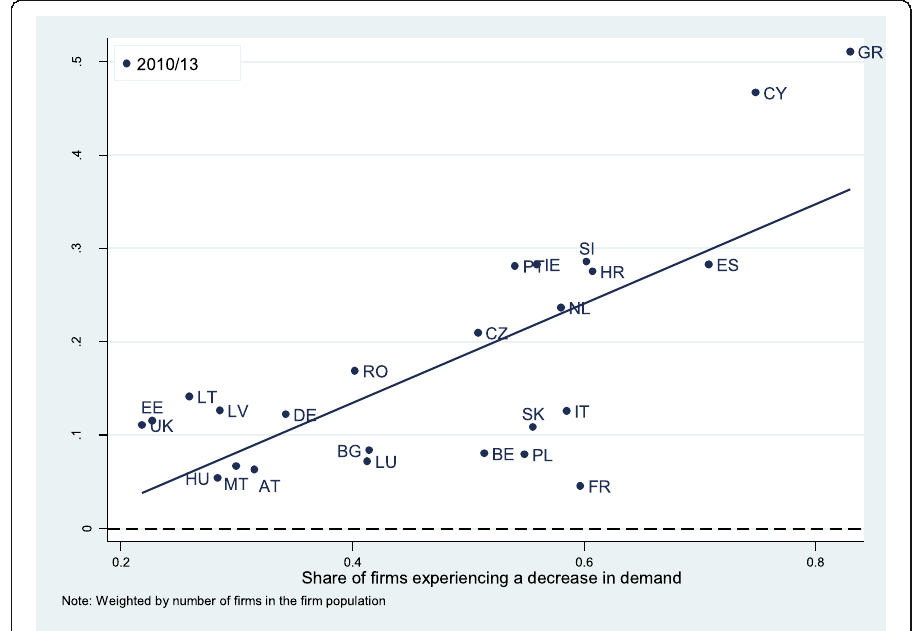
Fig. 1 Shocks to firm demand and reductions in labour costs